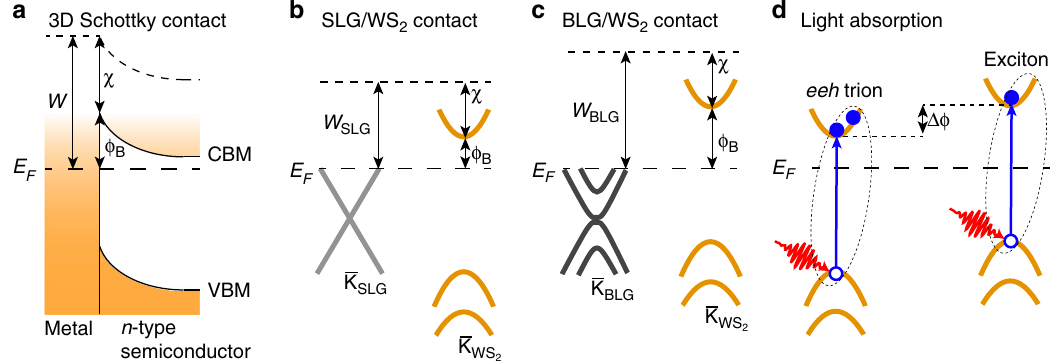
Fig. 5 Interpretation of band alignments and luminescence features. a Typical band diagram for a 3D Schottky contact between a metal and an n -type semiconductor. The double-headed arrows illustrate the alignments of work function W , Schottky barrier height ϕ B and electron af fi nity χ . b , c 2D Schottky alignment diagrams for b a SLG/WS 2 contact and c a BLG/WS 2 contact in UHV. The trend of the band alignments has been derived from the EDCs in Fig. 4. d Sketch of optically induced trion (electron – electron – hole (eeh) type) and exciton processes in SL WS 2 under a different bias Δ ϕ caused by the varying Schottky barrier heights. Full (hollow) spheres correspond to electrons (holes), the red arrow corresponds to an optical pulse and the blue arrow signi fi es an electron – hole pair